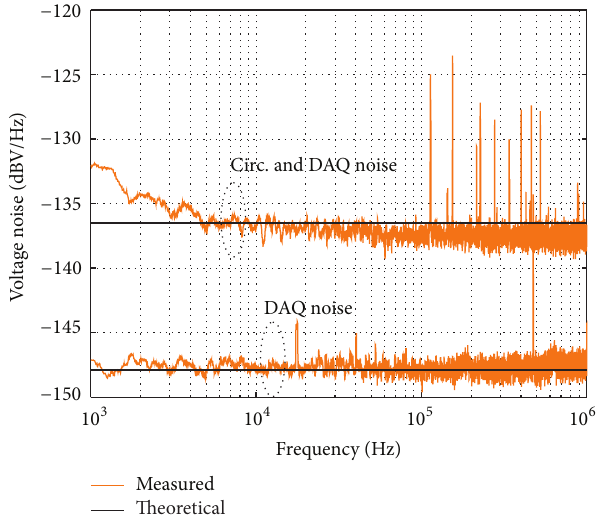
Figure 11: Internal noise, calculated and measured.